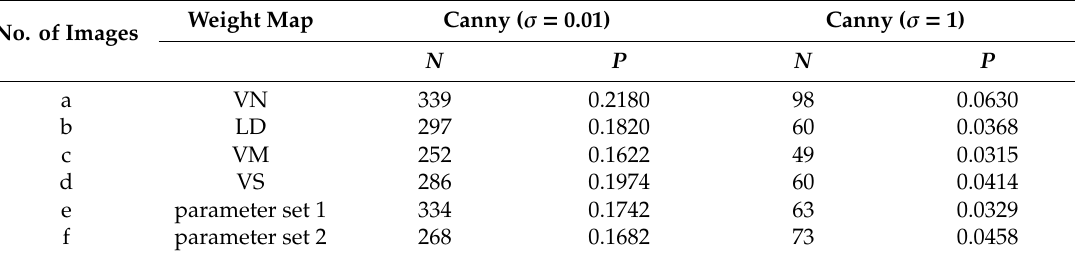
Figure 6. The stitch line results with different weight map: ( a ) VN, ( b ) LD, ( c ) VM, ( d ) VS, ( e ) WM with parameters 0.1, 0.2, 0.2, 0.5, and ( f ) 0.1, 0.1, 0.25, 0.55. Table 3. Evaluations of fusion e ff ects in Figure